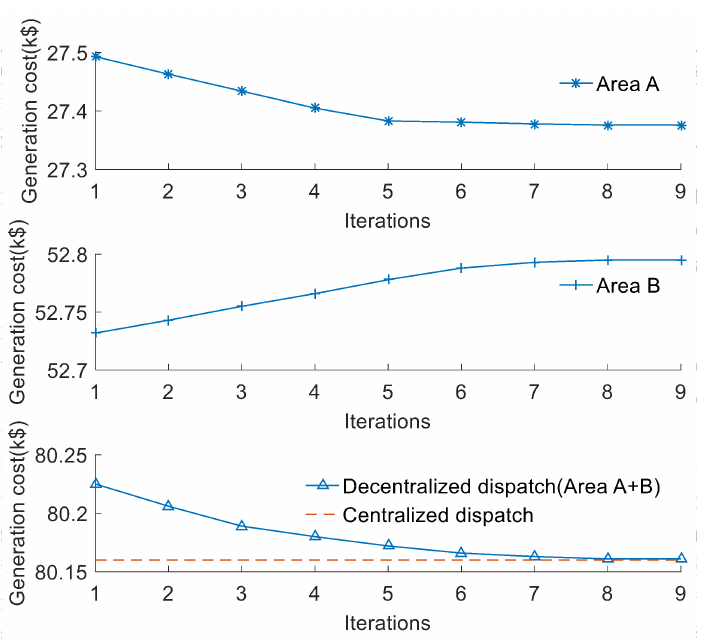
Figure 7. The convergence curve of generation cost of interconnected power system.